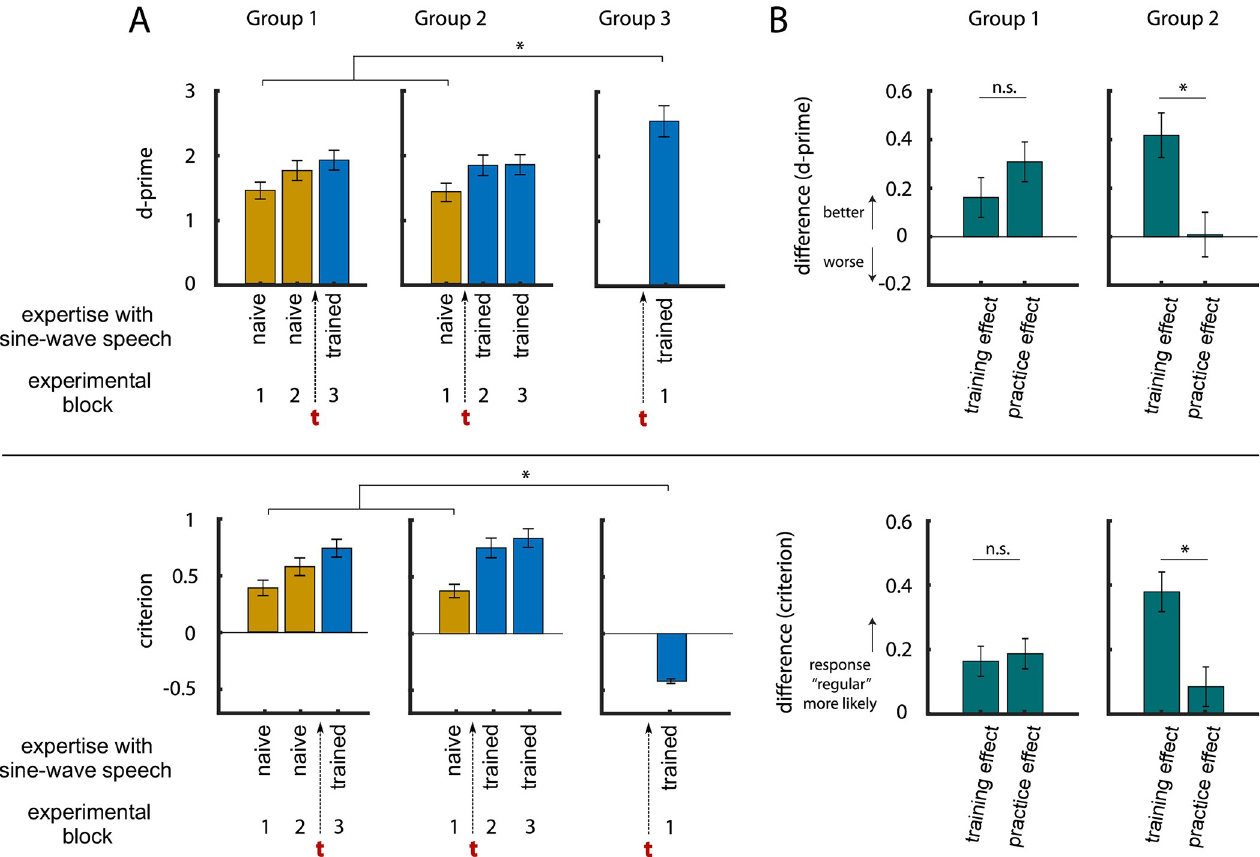
Fig 6. A. Sensitivity (d-prime, top) and response bias (criterion, bottom) in the three groups during irregularity detection in Experiment 3, and how they develop with expertise with sine-wave speech. The red t shows when participants completed training. Error bars show SEM, corrected for between-participant variation. B. In Groups 1 and 2, some of the experimental blocks (shown in A) were contrasted to reveal training (block 3–2 in Group 1, block 2–1 in Group 2) and practice effects (block 2–1 in Group 1, block 3–2 in Group 2), respectively.